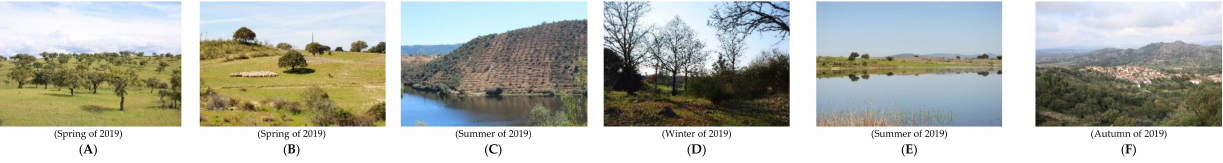
Figure 4. Representative pictures of the most common landscape typologies in the study area. These were used to evaluate preferences by pairwise comparison. ( A ) Dehesa/Montado. ( B ) De- hesa/Montado with stockbreeding. ( C ) Traditional olive grove. ( D ) Forest and scrubland. ( E ) Rivers and water bodies. ( F ) Rural